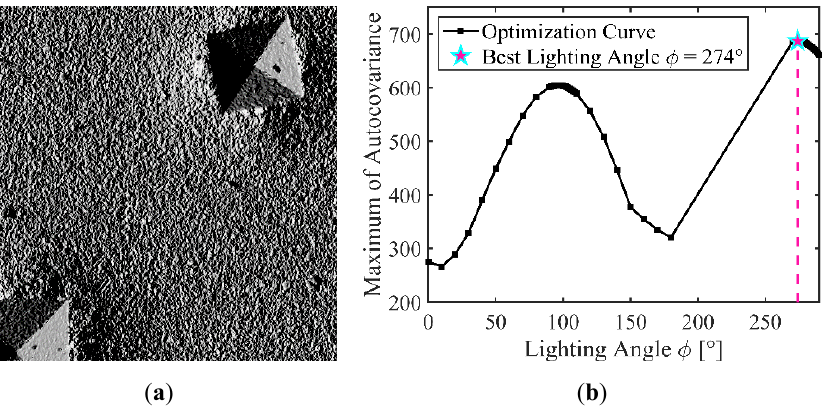
Figure 5. Optimized reflectance map of an indented surface ( a ) and optimization curve ( b ), where each square is a tested lighting angle ϕ solution, obtained with the two-step reflectance optimization ( θ light = 90°).